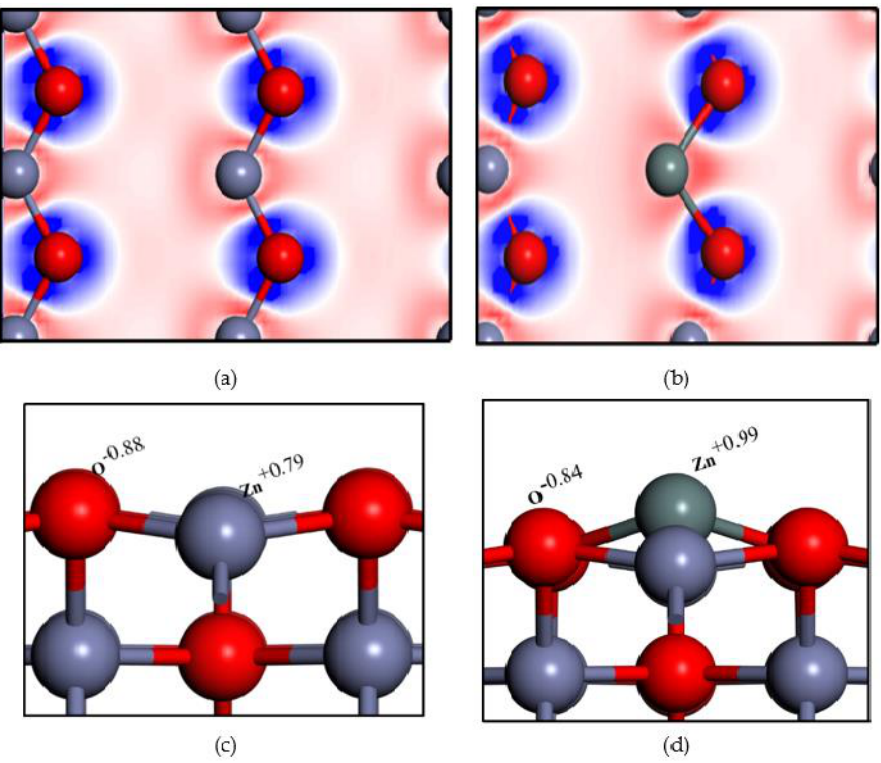
Figure 7. Electrons and charge distribution plots for ( a , c ) ZnO (101) surface and ( b , d ) Sn − doped ZnO (101) surfaces, respectively. Red – blue scale (isosurface range −0 .14; +0.14).